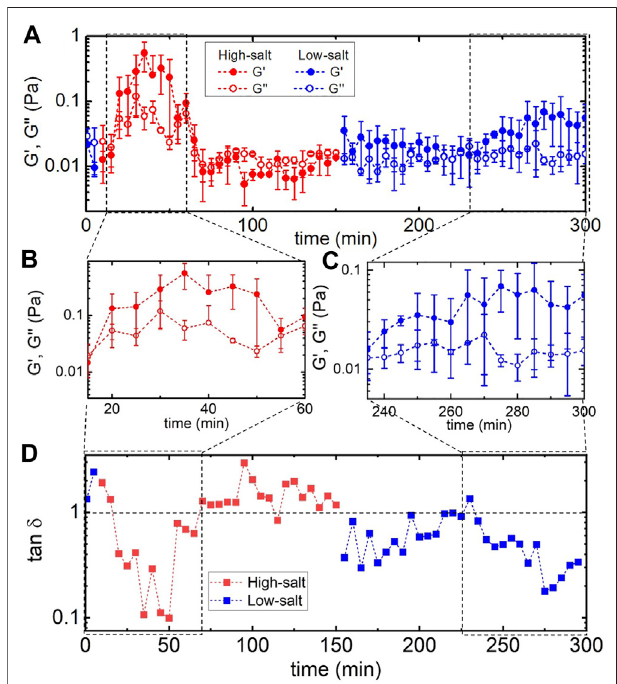
FIGURE 2 | Actomyosin networks display non-monotonic and irreversible changes in viscoelastic properties during in situ cycling of [Mg 2+ ] and [K + ]. (A) Linear elastic and viscous moduli, G ′ ( fi lled) and G ″ (open), of actomyosin networks during a complete cycle of salt modulation - starting ( t (cid:1) 0) in “ low-salt ” conditions (1 mM MgCl 2 , 50 mM KCl) (blue), switching to “ high-salt ” (500 mM MgCl 2 , 200 mM KCl) until t (cid:1) 150 min (red), then returning to “ low-salt ” (1 mMMgCl 2 , 50 mMKCl) conditions(blue) forthe remaining duration of the 300 min measurement. Each data point is an average over fi ve frequencies across two replicates and error bars are standard error. Boxed-in regions highlight times in which G ′ increases substantially. Zoom-ins of these regions are shown in (B) and (C) . Switching from low-salt to high-salt conditions leads to a nearly ∼ 100x increase in G ′ followed by rapid drop. Upon reintroducing the initial low-salt conditions G ′ slowlyincreasestovalueswellabovethestartingvalues. (D) Losstangent,tan δ , versus time for the full time course of the experiment, highlighting the complex variation in the elastic storage of the network during salt modulation. Dashedhorizontallineindicates G ′ (cid:1) G ″ .Fordatapointsbelowthisline,elastic storage dominates the response over viscous dissipation, with smaller tan d values indicating more elastic-like